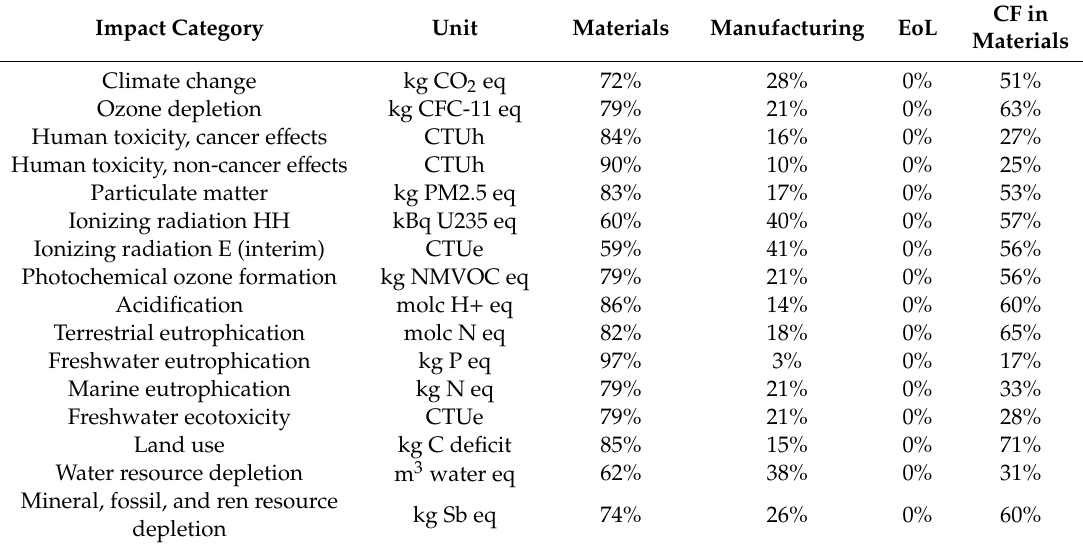
Percentage contribution of each inventory aspect to each impact category for the handbrake